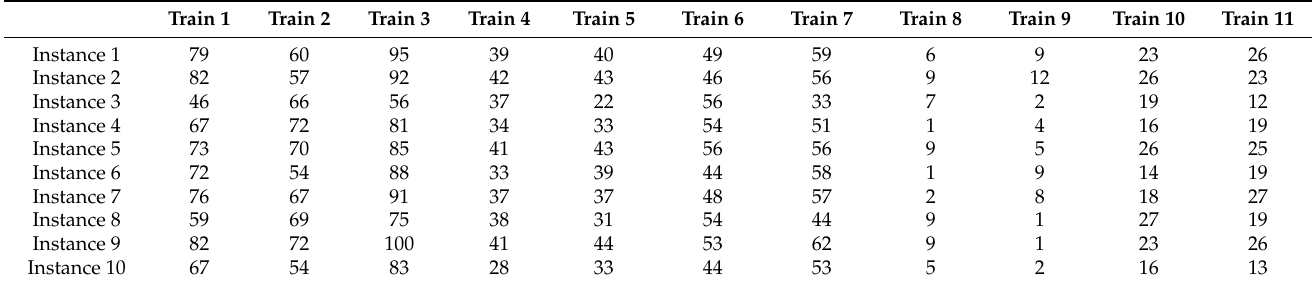
Table 11. Entrance times of the trains into the system, with respect to time zero (minutes).